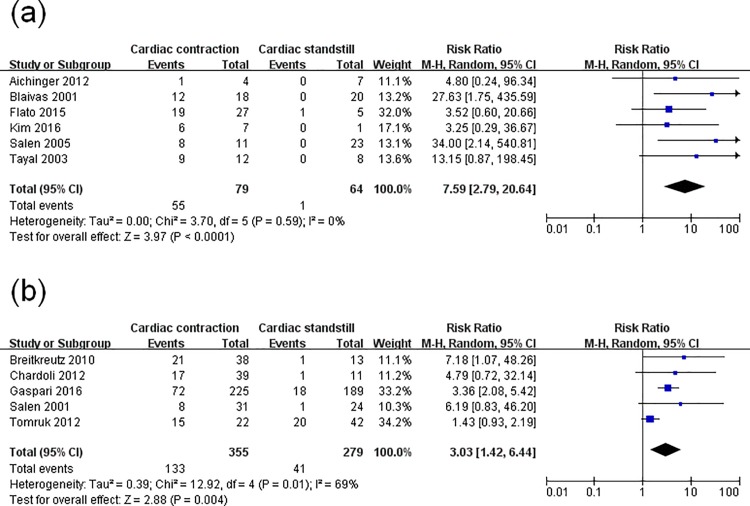
Forest plot of the subgroup analysis of cardiac activity on the restoration of spontaneous circulation.(a) studies whose sample size was n<50; (b) studies whose sample size was n≥50.